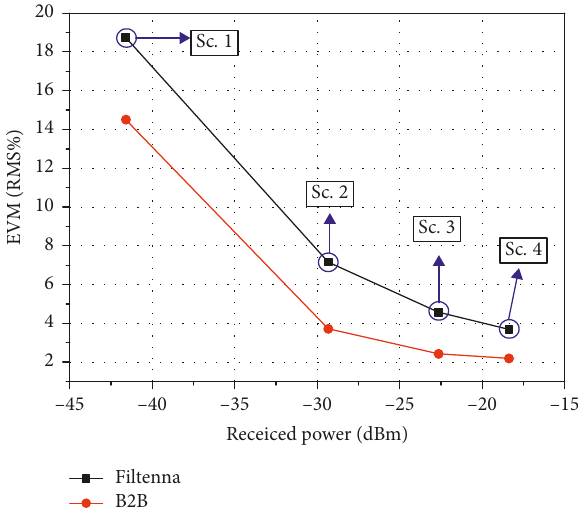
Figure 12: EVM as a function of the received power for four different